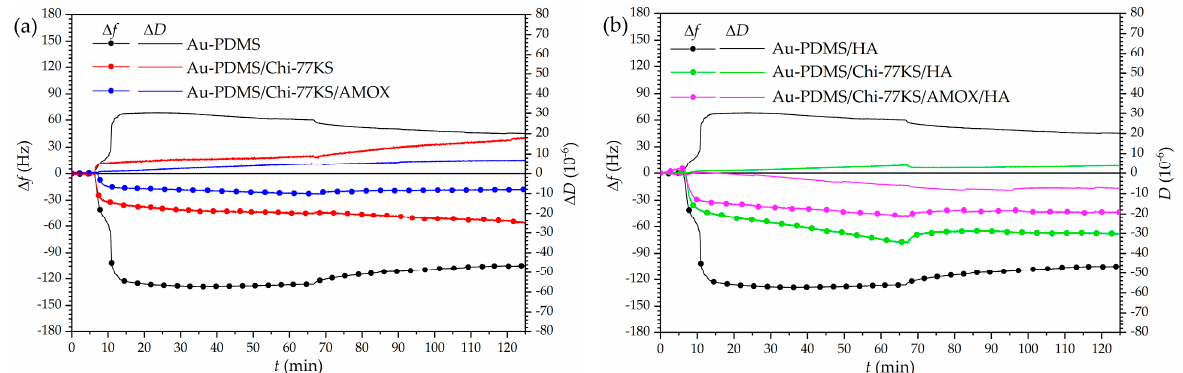
Figure 8. Changes in QCM-D frequency ( a ) and dissipation shift ( b ) as a function of time for the adsorption of the Mix onto Au-PDMS, Au-PDMS/Chi-77KS, Au-PDMS/Chi-77KS/AMOX [35], Au-PDMS/Chi-77KS/HA, and Au-PDMS/Chi- 77KS/AMOX/HA surfaces.